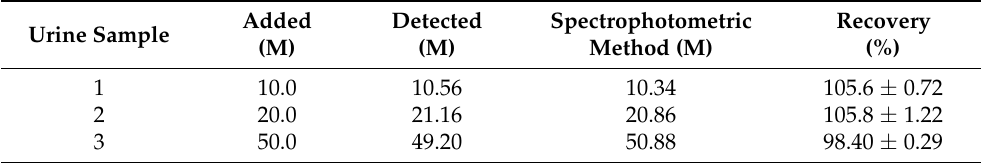
Table 5. Detection of AA in real human urine samples with h-nPG modified